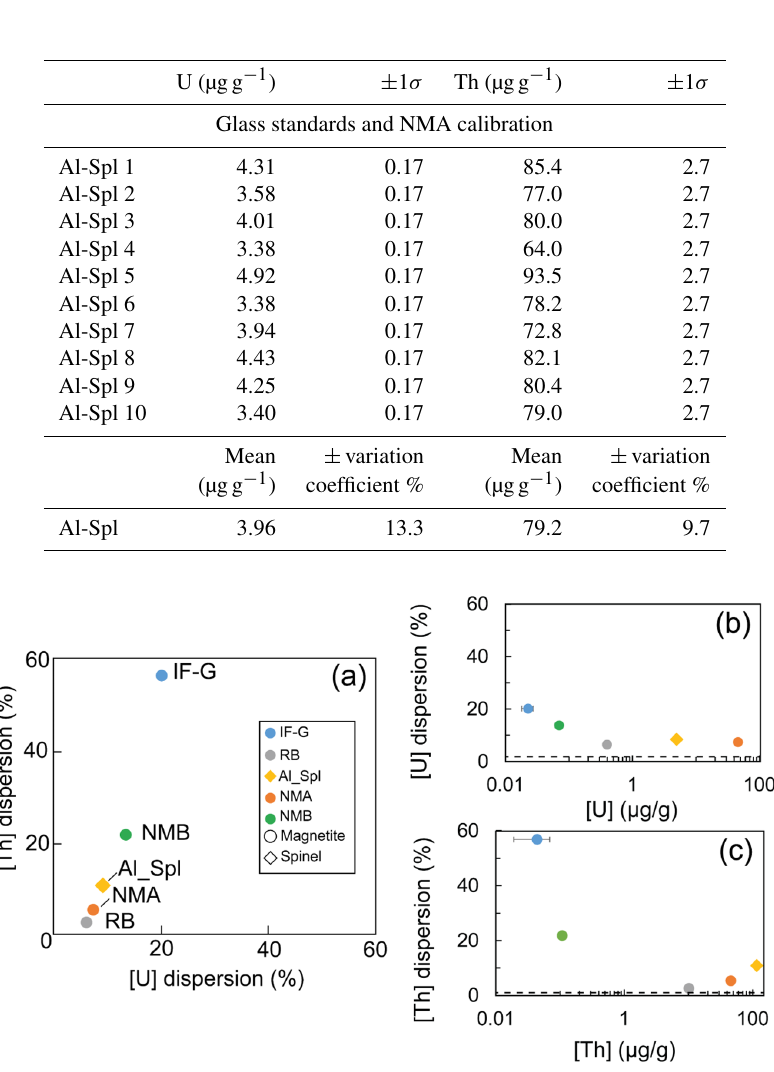
Figure 3. (a) Dispersion of the U and Th concentrations obtained by wet chemistry sampling. (b, c) Mean U and Th concentrations as a function of the associated dispersion, respectively. Dash lines are the minimum uncertainty of U and Th derived from counting